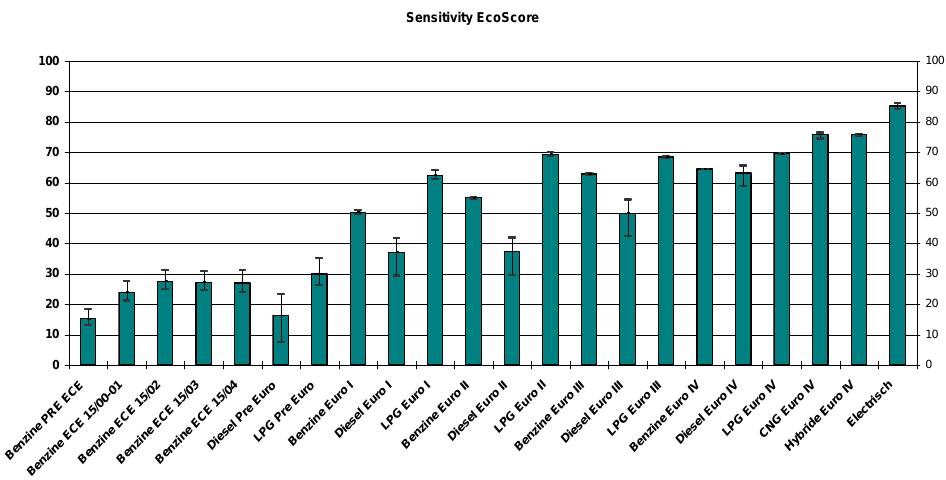
Figure 7. Sensitivity analysis – maximum deviation on the end